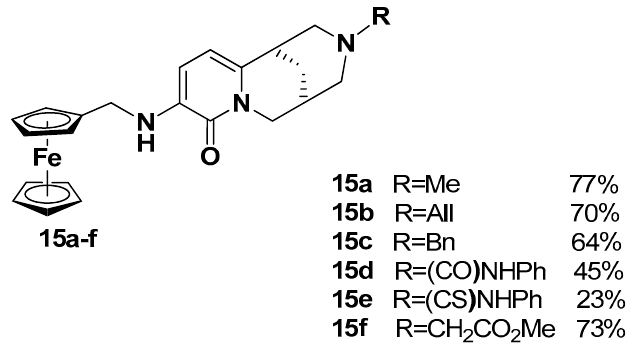
Figure 8. Ferrocene containing cytisines modified at the N3 atom.